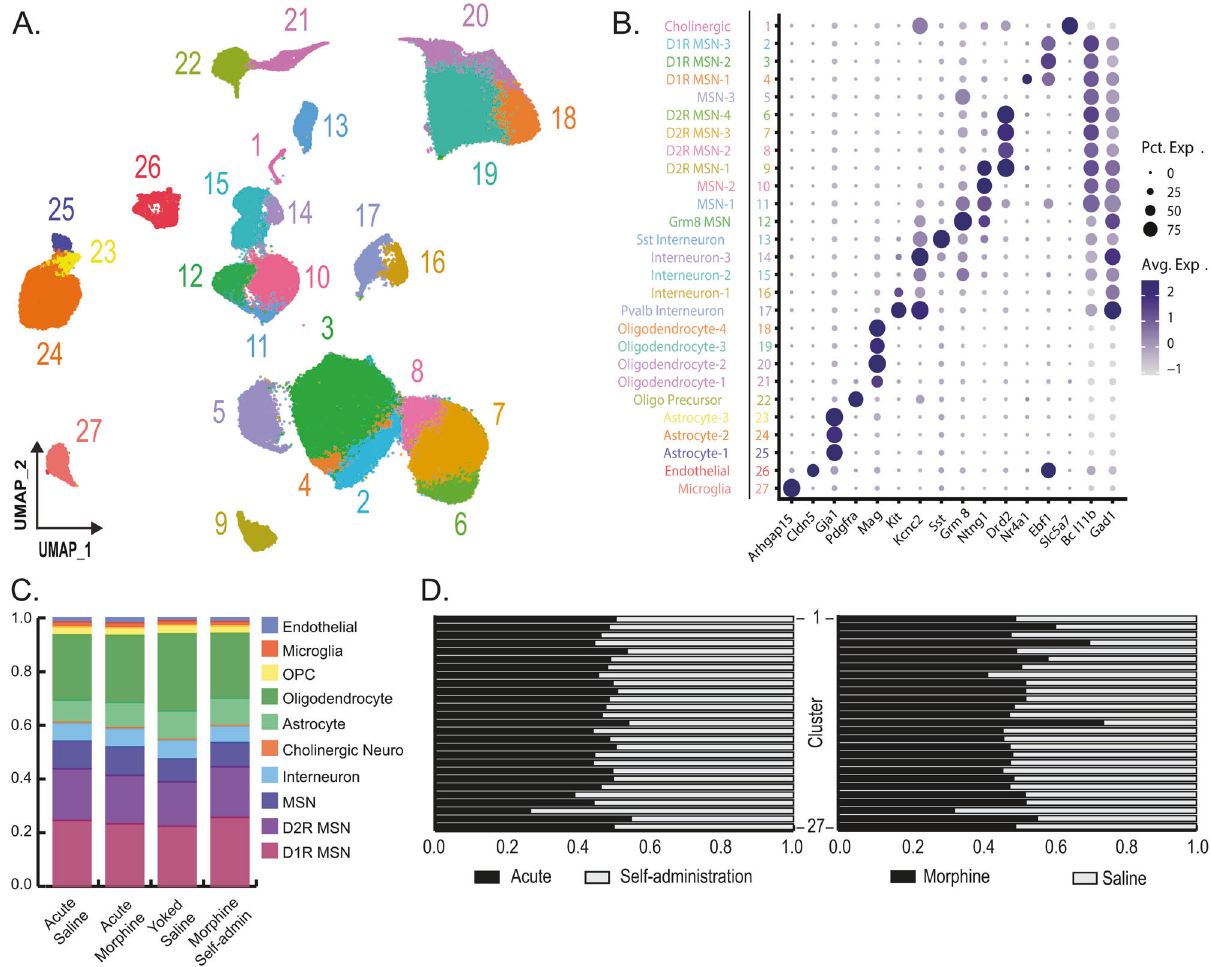
Fig. 2 snRNAseq and clustering. A After quality controls, ~190,000 nuclei pro fi les were used for unbiased clustering in Seurat and are presented as a uniform manifold approximation and projection (UMAP) dimension reduction plot of all nuclei color-coded by cluster. B Clusters were annotated with genes known to be markers for major neural cell types. The size and color of dots are proportional to the percentage of cells expressing the gene (Pct. Exp.) and the average expression level of the gene (Avg. Exp.), respectively. The cluster numbers and colors are matched to that of the UMAP. C The proportion of major cell types in the saline and morphine group for the acute and chronic self-administration (SA) experiment. D The proportion of nuclei in each cluster coming from either the acute or chronic self-administration experiment (left) and the morphine or saline group treatment (right). Clusters are in descending